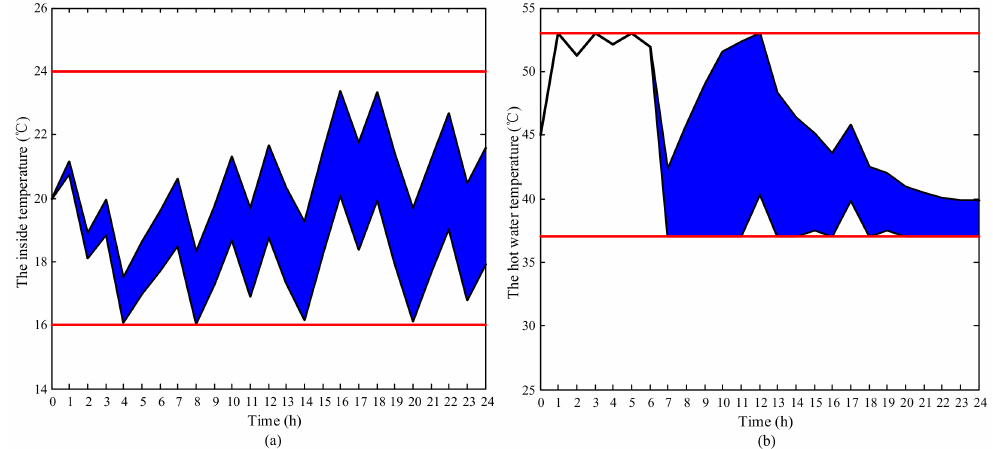
Figure 5. ( a ) The actual temperature range of the air in room (under the complete robust schedules); and ( b ) the actual temperature range of the hot water in tank (under the complete robust